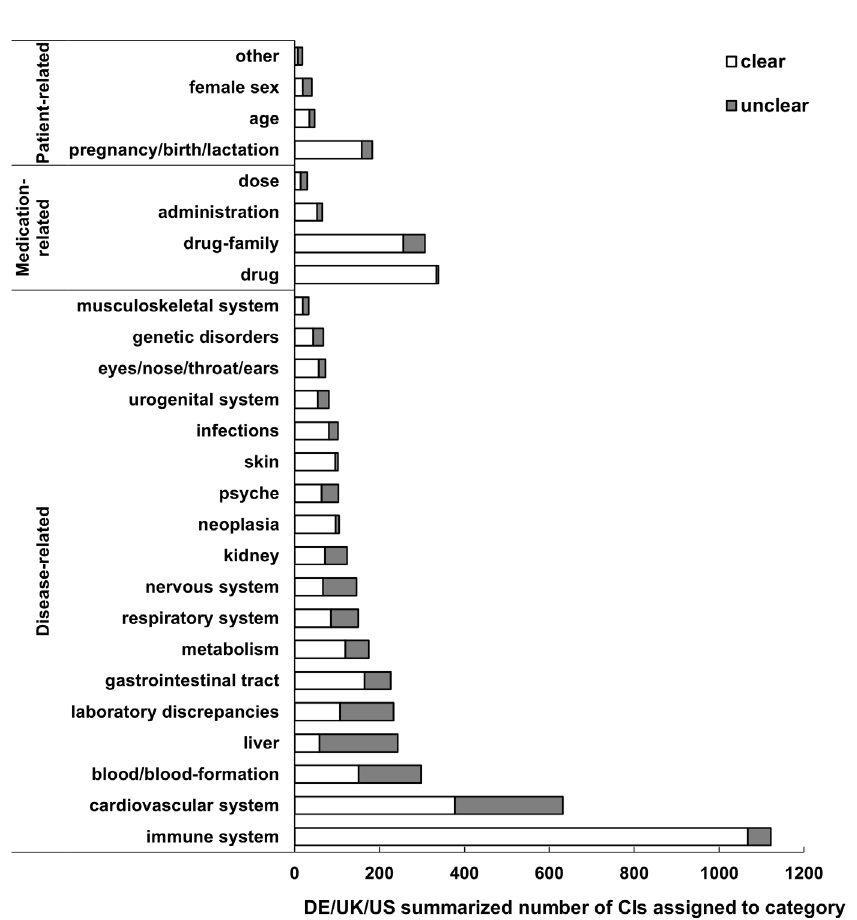
Figure 4. The average clarity from the prescriber perspective of all absolute CIs in German and UK SmPCs and US PI is shown in total numbers of individual CIs assigned to each category, summarized for Germany, UK and US. The three categories patient-, medication- and disease-related CIs are sorted by frequency among all CIs, as well as the individual subcategories. White: clear, grey: unclear. CI: contraindication, DE: Germany.